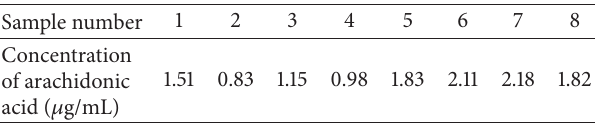
Table 3: Free arachidonic acid in some human plasma samples. Sample number 1 Concentration of arachidonic acid ( 𝜇